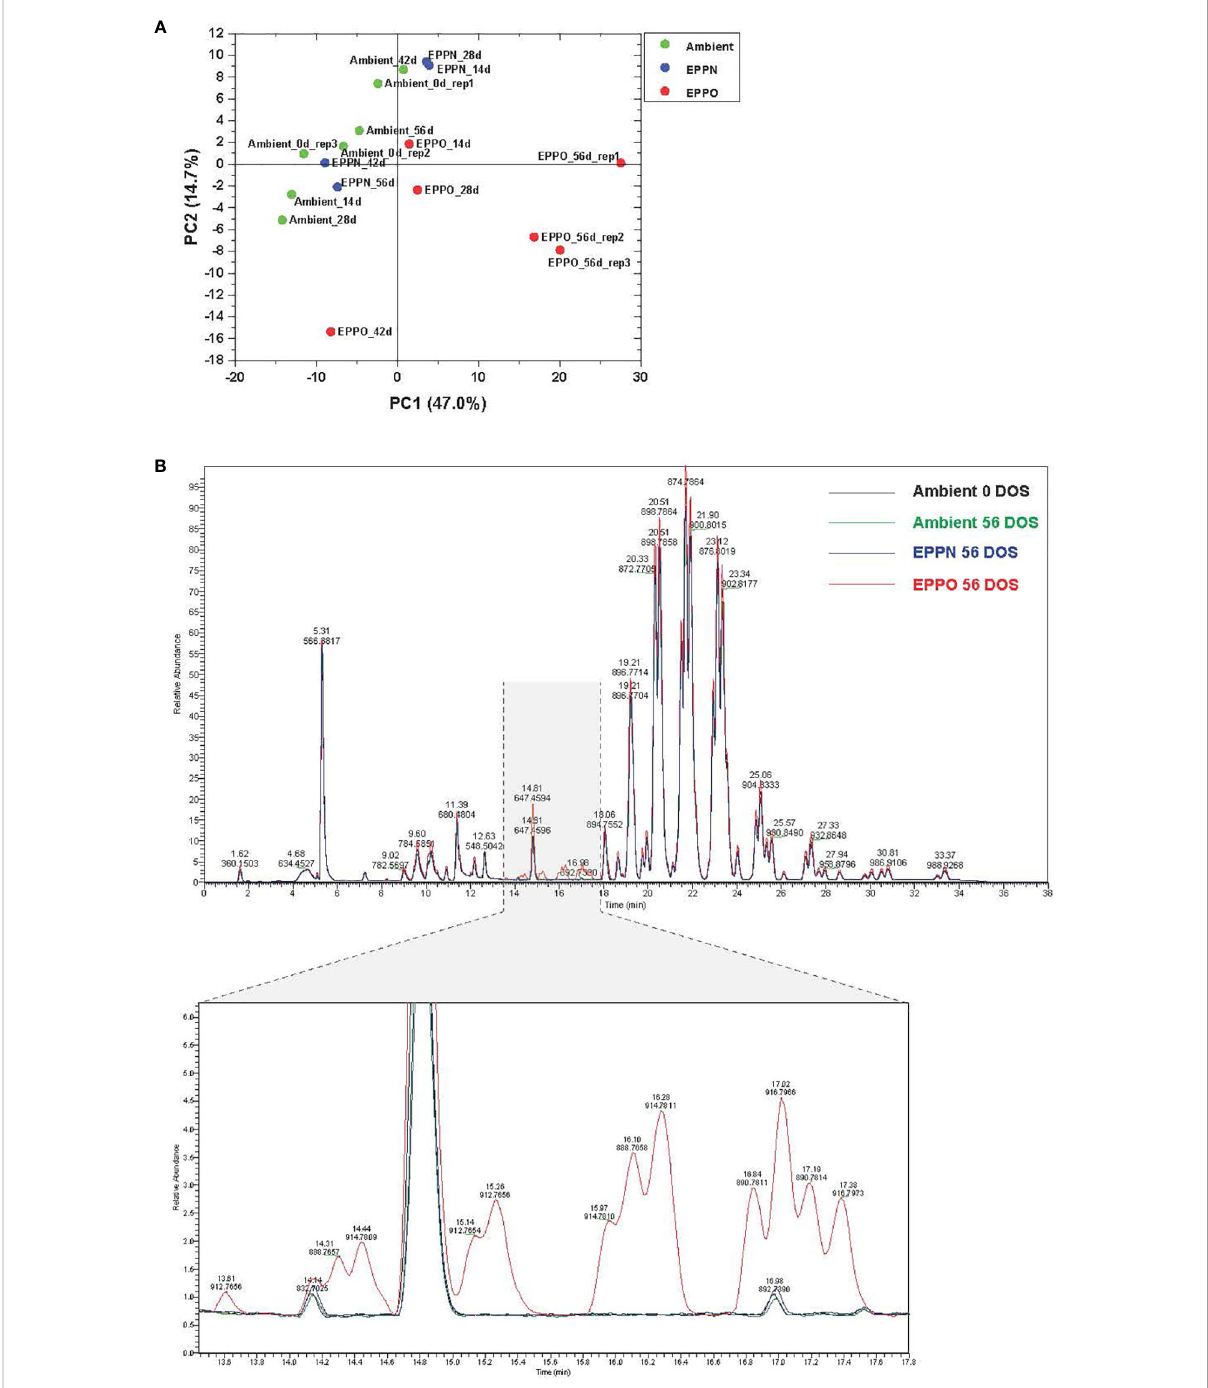
FIGURE 2 Lipid analysis of rice seeds stored under EPPO and its control conditions. (A) Principal component analysis based on the relative abundance of 300 lipid compounds. (B) Overlay of total ion chromatograms of several lipid species in rice seed samples from the ambient initial control (Ambient 0 DOS) or aged under different conditions for 56